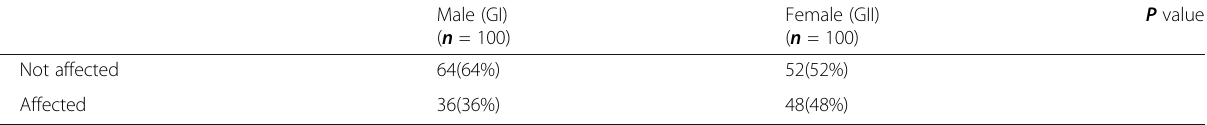
Table 7 Comparison between male and female teachers in Auditory Perceptual Assessment (Continued)